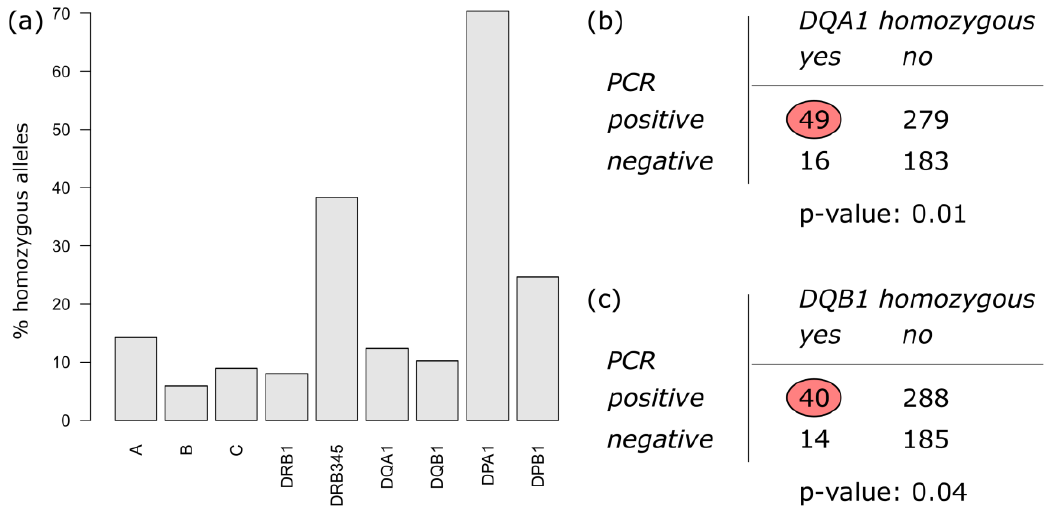
Figure 1. Distribution of HLA allele homozygosity in the cohort: ( a ) percent of homozygous alleles among the different genes. ( b , c ) 2 × 2 contingency tables of DQA1 and DQB1 homozygosity, stratified by PCR status, are shown along with corresponding p - values obtained from Fisher’s exact test.